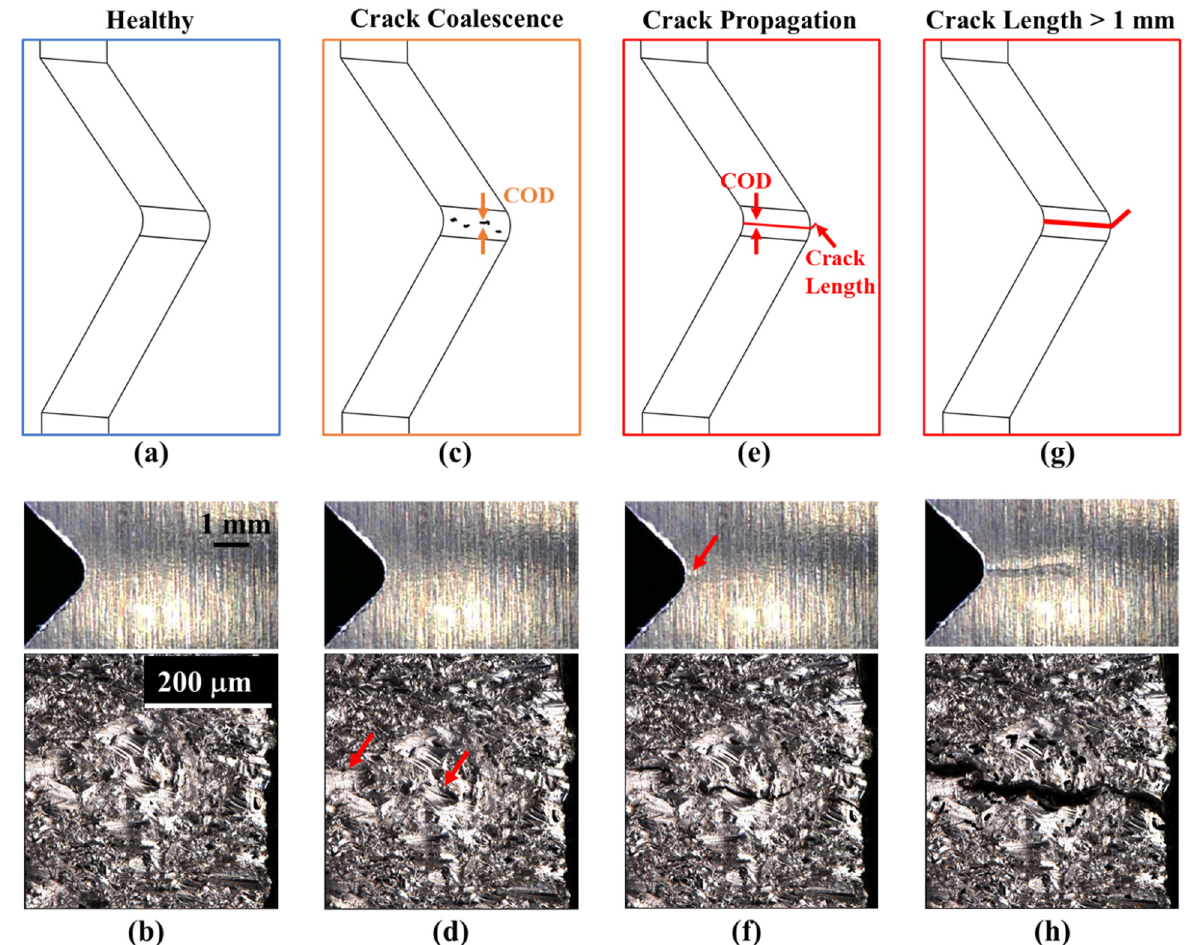
Figure 9. The chronology of failure as observed by the microscopes for a representative V-notched specimen—( a , b ) a healthy specimen, ( c , d ) crack coalescence regime where fine cracks (~3 µ m) appear at the notch root, ( e , f ) the cracks coalesce, and a single crack is observed at the notch root and on the side of the specimen, and ( g , h ) crack growth continues. The arrows indicate the emergence of a crack on the images. In ( b , d , h ), images on the top row are obtained from the digital microscope, and on the bottom row, they are obtained from the confocal microscope. The images obtained from the U-notched specimens are similar and are excluded for brevity.